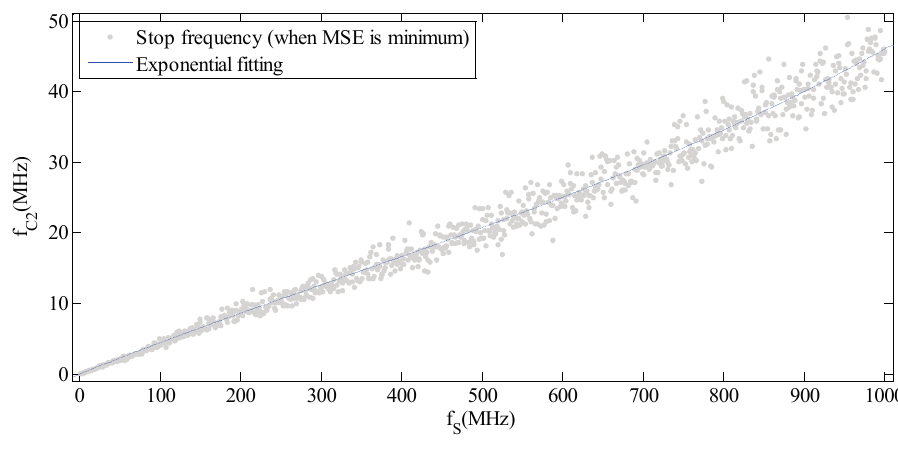
Figure 3. Relationship between f S and f C1 .